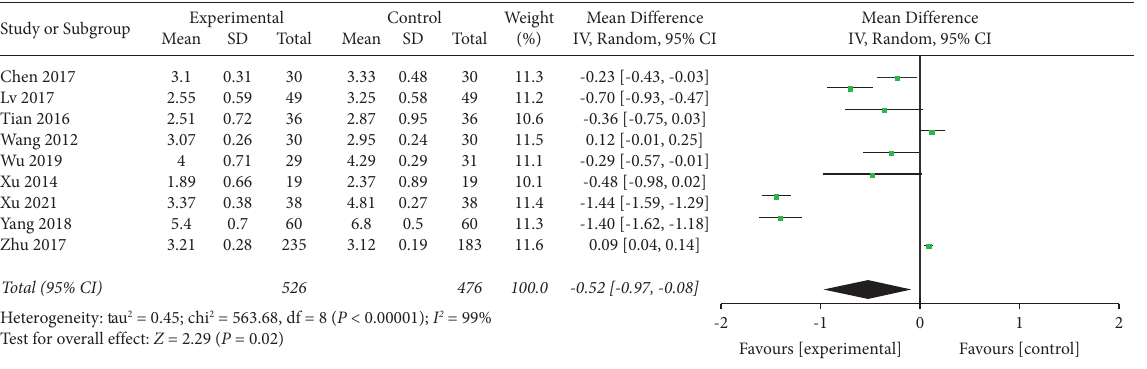
Figure 7: Comparison of the VAS at 48h between the AA group and the control group.